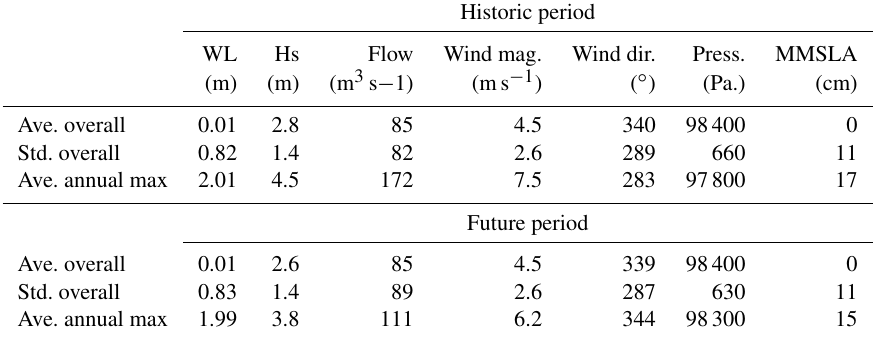
Table 2. Comparison of forcing for Tillamook Bay under the historic and future climatological periods. “Ave. Overall” is a full time series average while “Ave. Annual Max” is an average of forcing during observed annual WL maximum events. Historic period WL Hs Flow Wind mag. Wind dir. Press. MMSLA Ave.